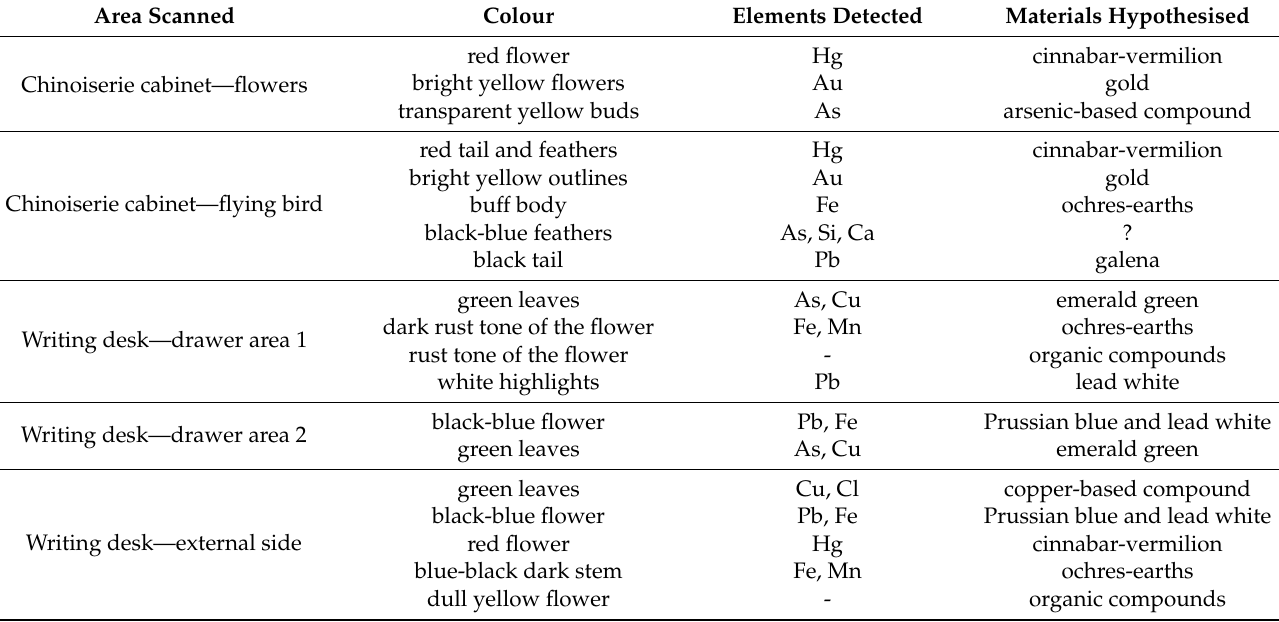
Table 3. Summary of the hypothesised materials employed in the different areas. Area